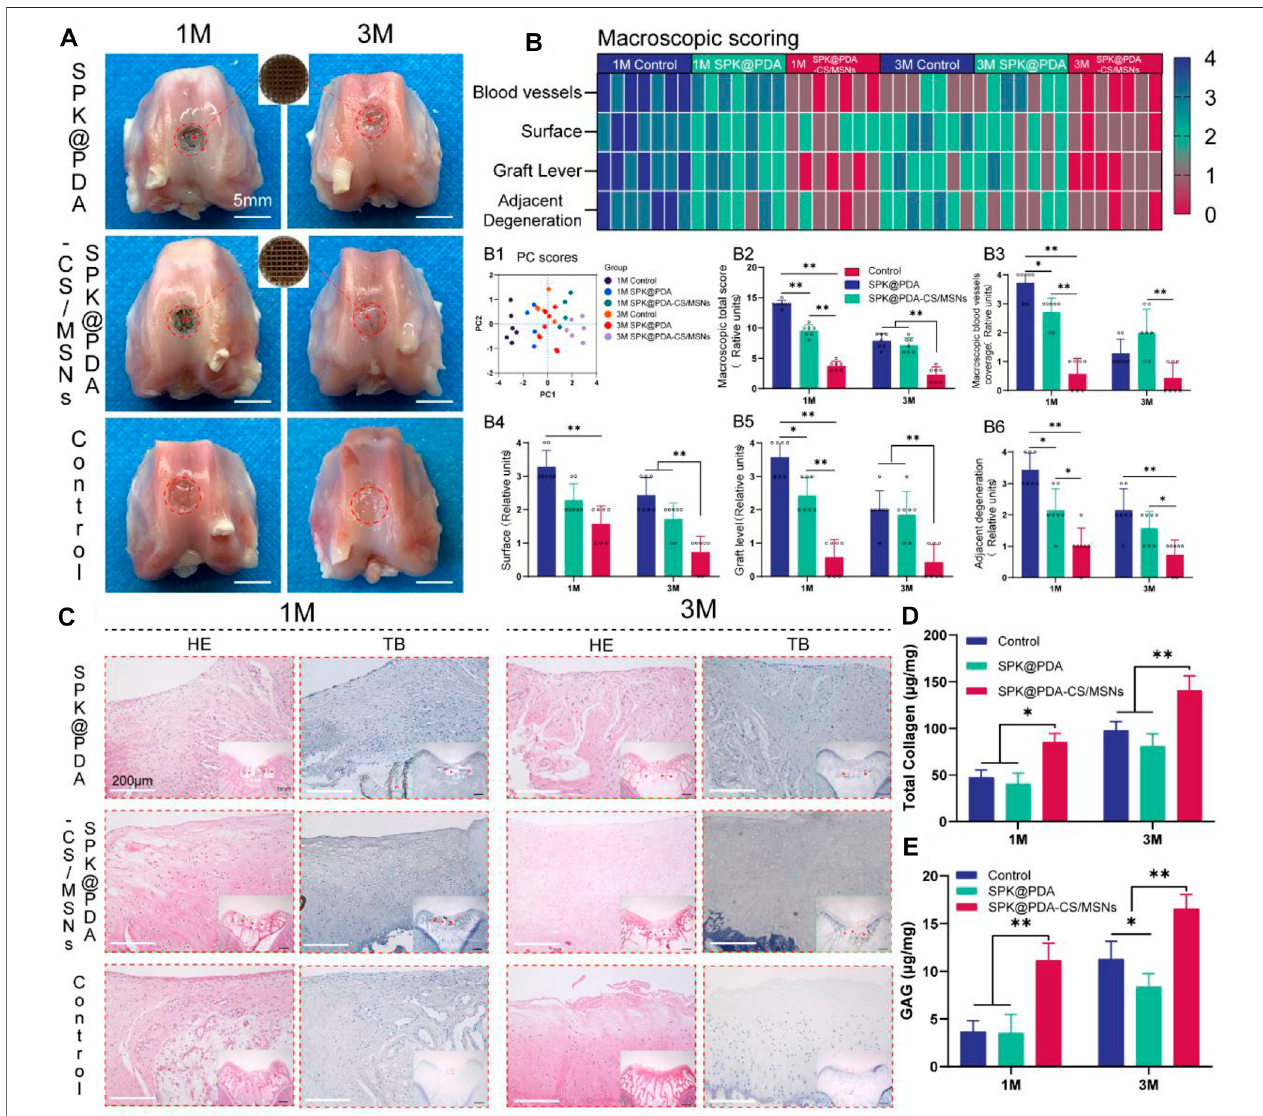
FIGURE 6 | Gross observation and histological analysis of cartilage defects treated with SPK@PDA and SPK@PDA-CS/MSNs scaffolds at 1 and 3 months after surgery. (A) Grossmorphologyoftherepairedtissue. (B) Heatmapofthemacroscopicscoringsystem.B1.Principalcomponentanalysisofthemacroscopicscore.B2. Totalmacroscopicscorecomparisonofdifferentgroups.B3-6.Comparisonofvariablesindifferentgroups,includingbloodvesselcoverage(B3),surface(B4),graftlevel (B5),andadjacentcartilagedegeneration(B6).Dataareshownasmean±SD, n =7,* p < 0.05,** p < .01. (C) Hematoxylin-eosin(HE)andtoluidineblue(TB)staining of the repaired tissue at 1 and 3 months after surgery, red arrows indicate residual PEEK scaffold. (D,E) Total collagen and GAG content of the repaired tissue at 1 and 3 months after surgery. Data are shown as mean ± SD, n = 3, * p < 0.05, ** p < .01.